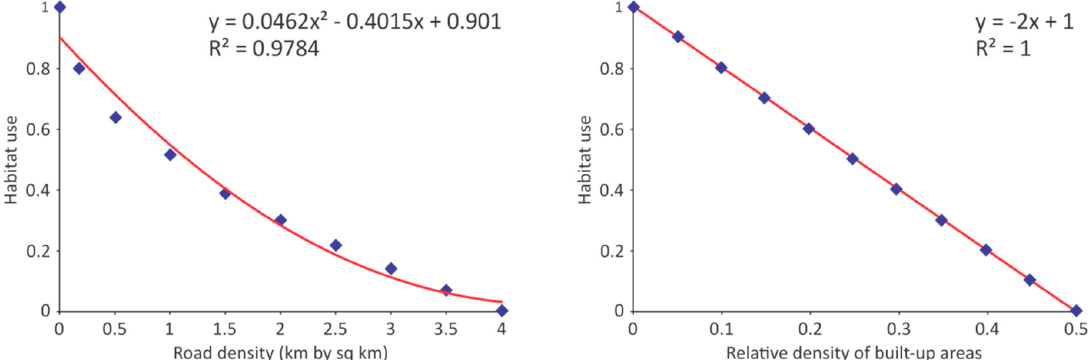
Figure 2. Relationship between red deer habitat utilization and: ( a ) road density, data after [30]; ( b ) relative density of built-up areas. Equations are ours.